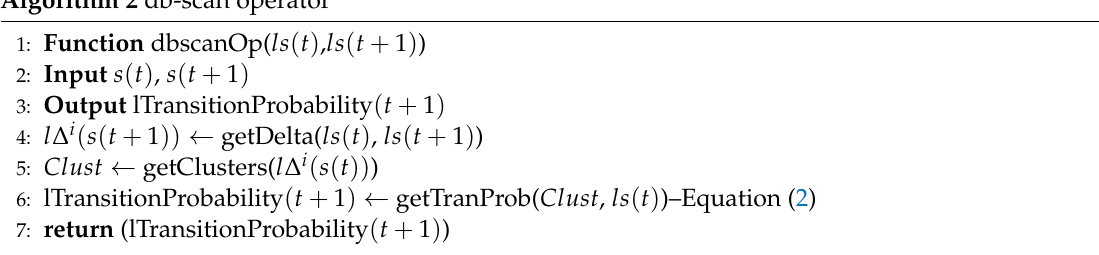
Algorithm 2 db-scan operator